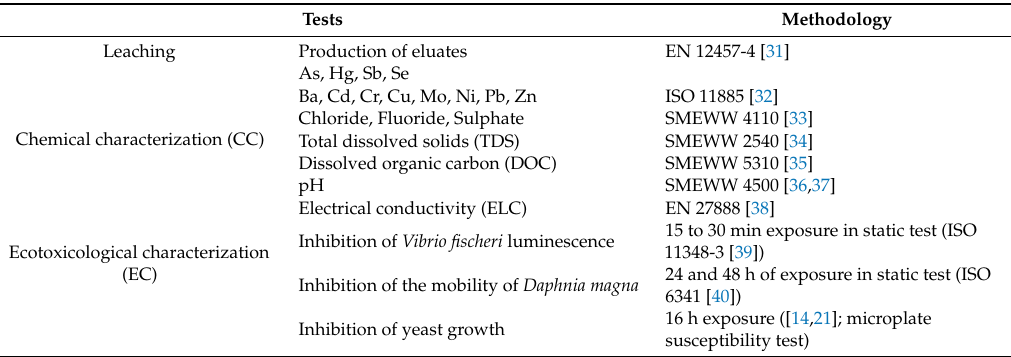
Table 4. Testing